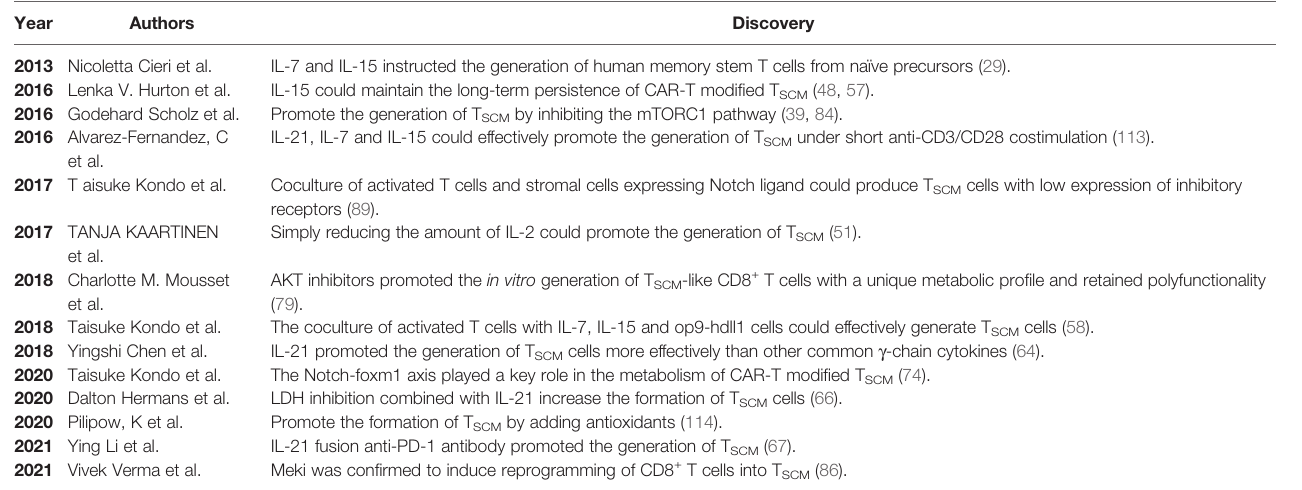
TABLE 2 | Key discoveries in the formation of induced culture T